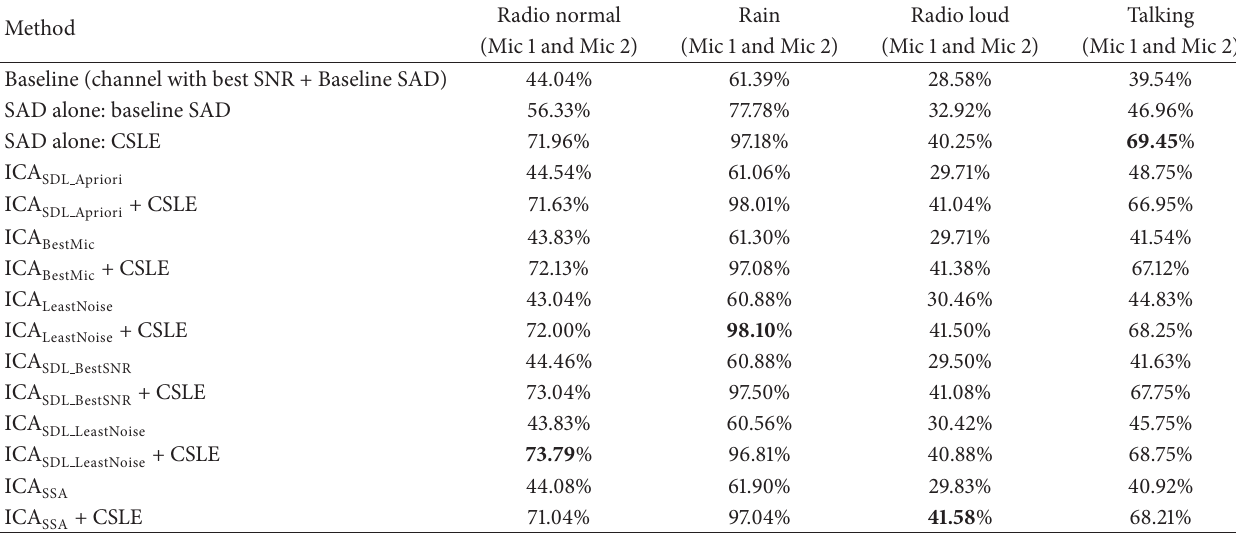
Table 3: Classification accuracies of various combinations of source separation and sound activity detection methods for one of the microphone configurations of the noisy SDL database, across four different noise configurations. Despite this, source separation methods do provide relative reductions in error rate of up to 7%, 48%, and 2% compared with CSLE alone for the radio normal, rain, and radio loud conditions, respectively.